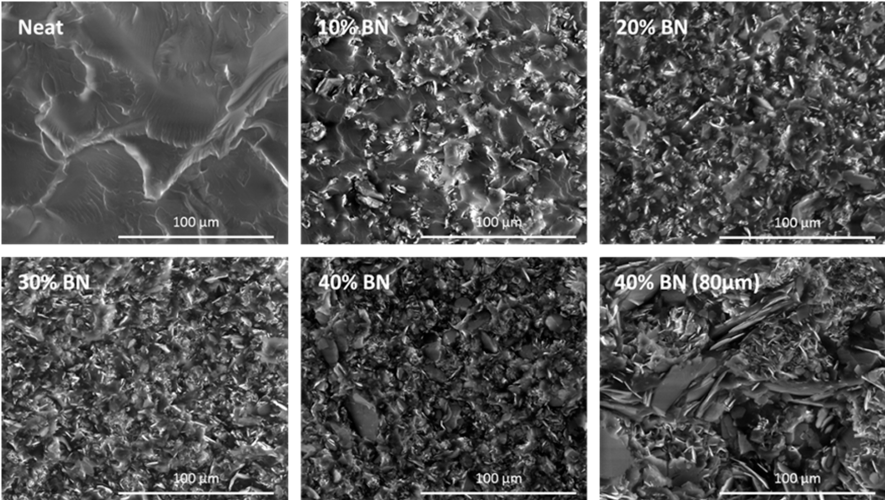
Figure 7. ESEM micrographs of fracture surfaces of the materials prepared at 800 magnifications.